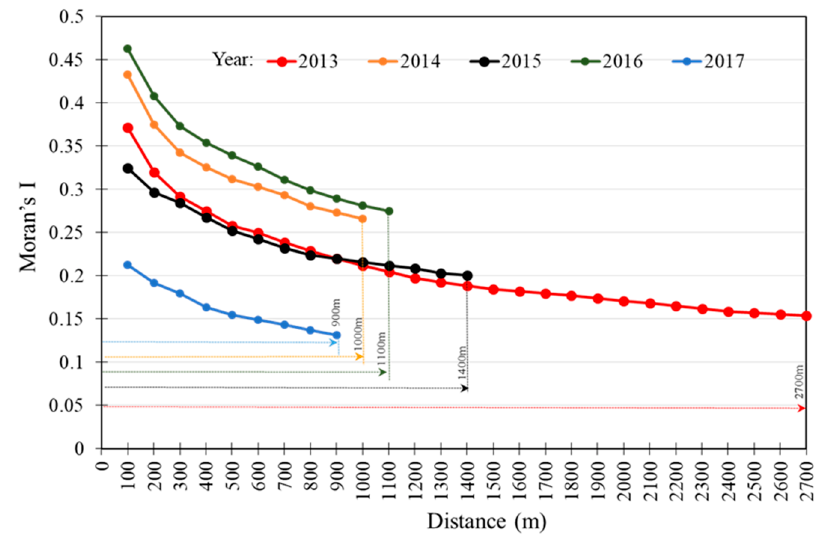
Figure 1. Spatial autocorrelation (Moran’s I) of real estate prices (2013–2017) with grid size 100 × 100.